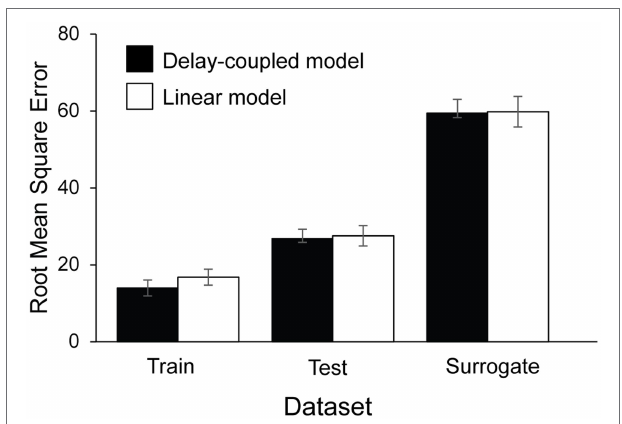
FIGURE 7 | Root Mean Squared Error computed between the model’s predicted asynchronies and the participants’ observed asynchronies, by dataset and Model type.